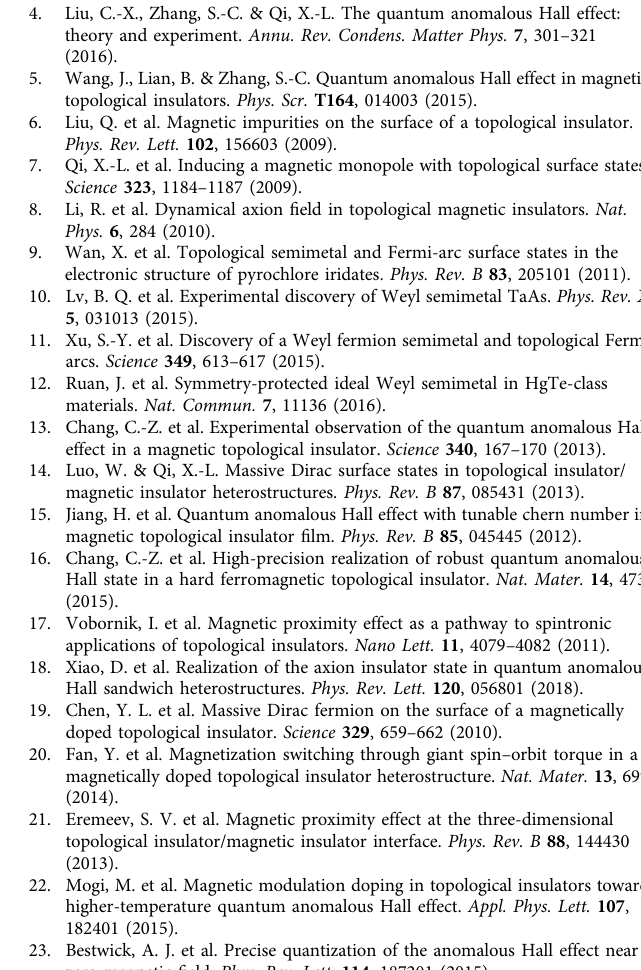
Magnetic measurements . A vibrating sample magnetometer equipped in a physical property measurement system (Quantum Design) is used to measure the magnetization of bulk crystals. The measured crystals are about 0.5 – 1mm in thickness and 2 – 3mm in side length. Standard copper sample holders are used during the measurement. The lowest temperature and highest magnetic fi eld are 2K and 9T, respectively.